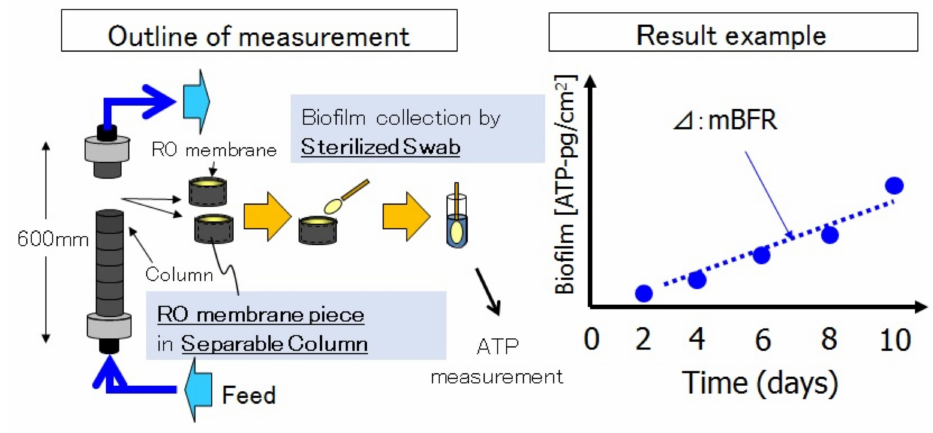
Figure 20. “mBFR”: Membrane biofilm formation rate [7,37,38].